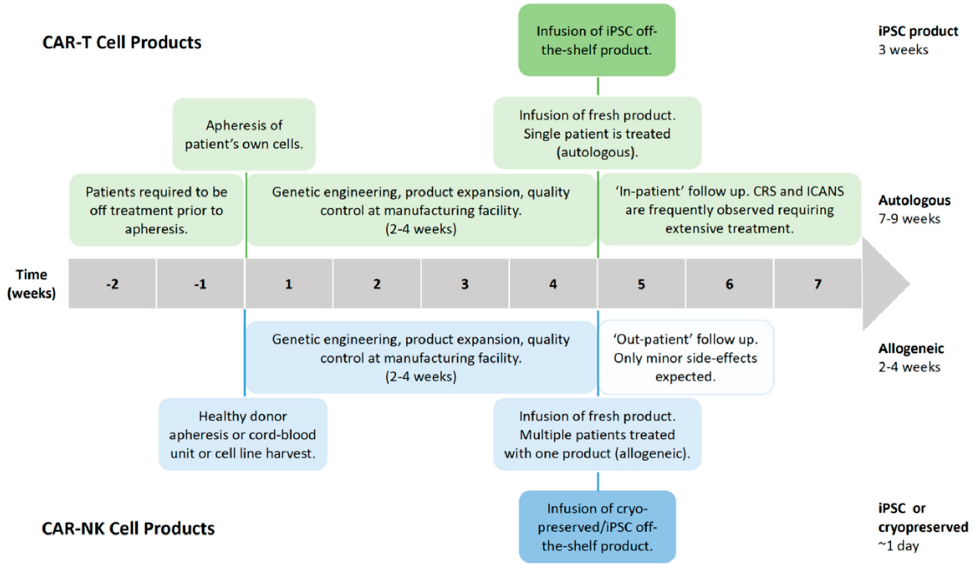
Figure 2. Manufacturing timeline of CAR-T cell and CAR-natural killer (NK) cell products. Comparison of the manufacturing time for CAR-T and CAR-NK cell products, from harnessing the cells for product processing to patient monitoring after treatment. Abbreviations: CRS, cytokine release syndrome; ICANS, immune effector cell-associated neurologic syndrome; iPSC, induced pluripotent stem cell.